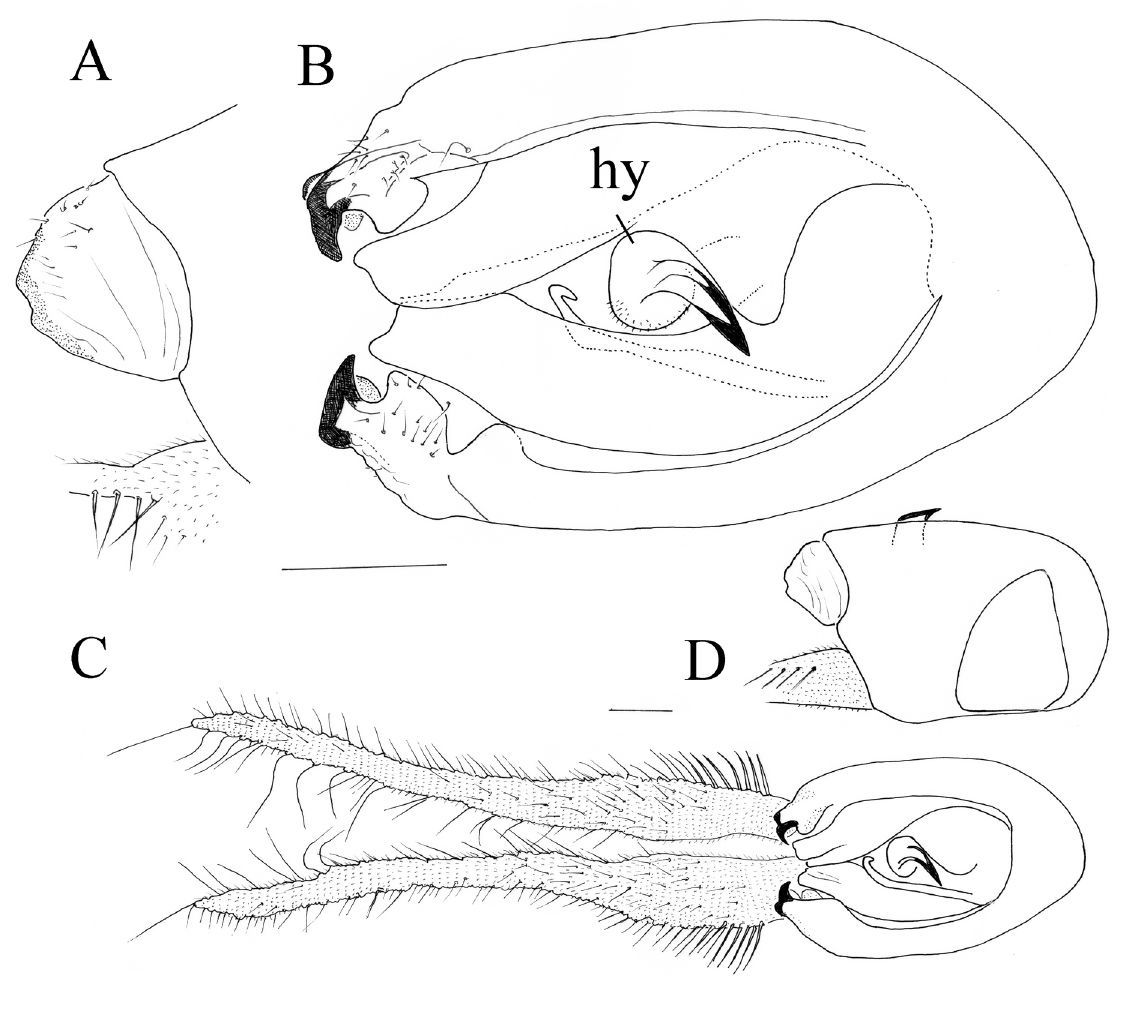
Fig. 6. Rhaphium canniccii sp. nov., holotype, ♂, terminalia (RBINS). A . Surstylus, lateral view. B . Epandrium, ventral view. C . Epandrium with cerci ventral view. D . Epandrium, lateral view. Abbreviation: hy = hypandrium. Scale bars: 0.1